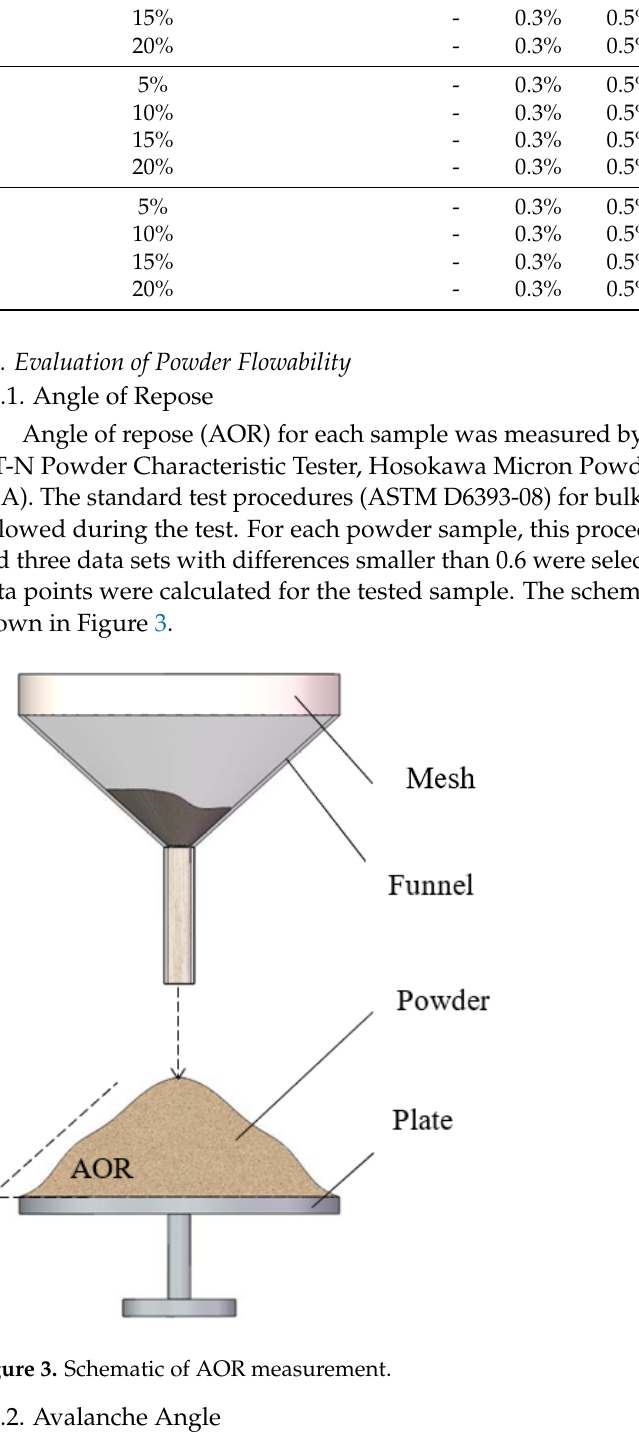
Table 3. List of 66 FPP samples .